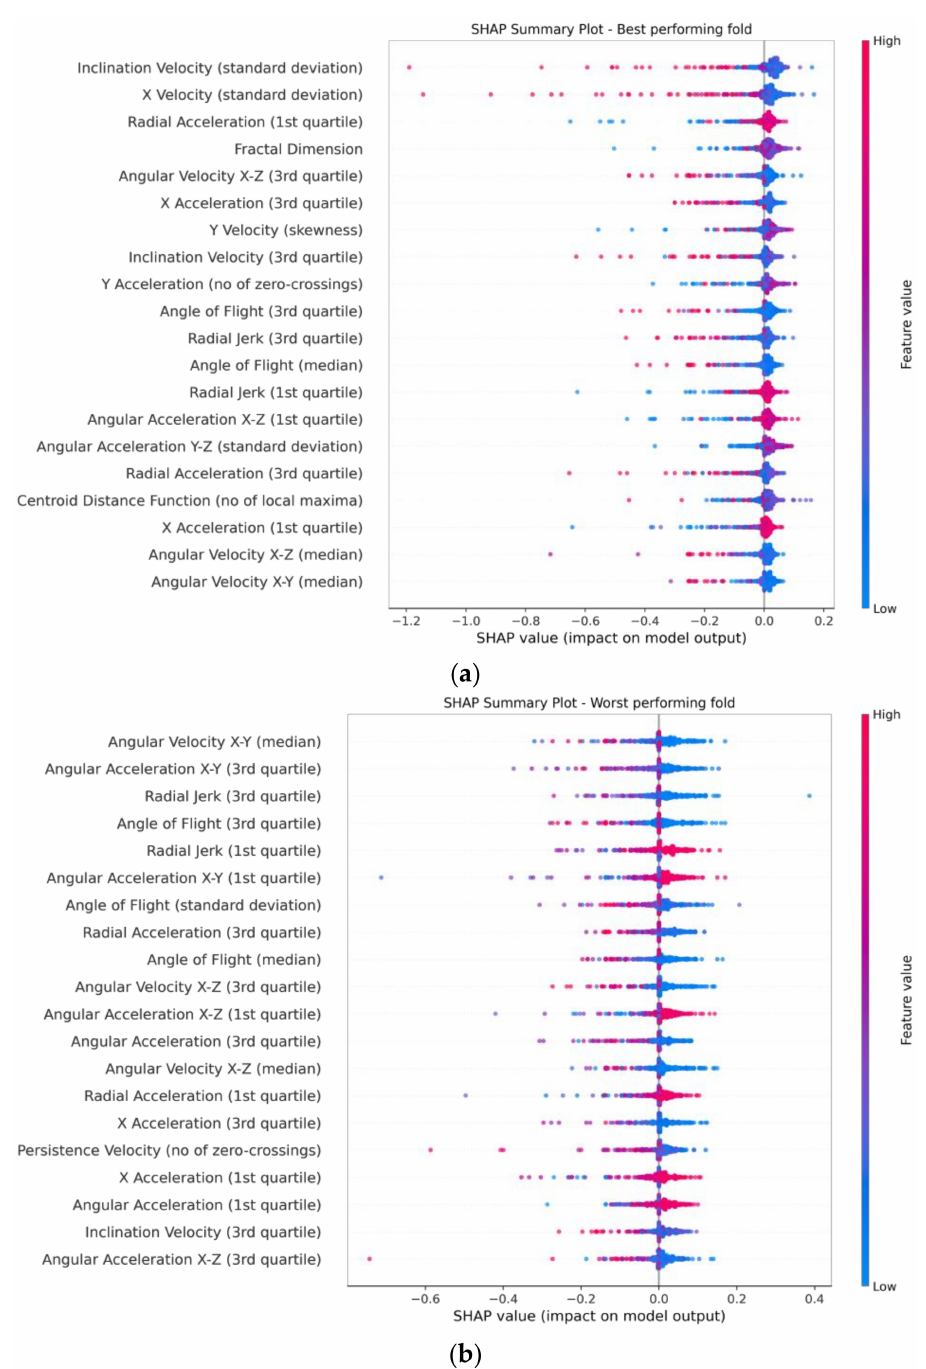
Figure 6. SHAP summary plot displaying the contributions of each feature to the model. The features are ordered by absolute feature contribution and the top twenty are displayed. A full list can be found in Figures S9 and S10. Each dot represents a segment, with its colour displaying its feature value. Positive SHAP values contribute towards the male class, while negative values contribute to the non-male class. ( a ) Summary plot of the best-performing fold. ( b ) Summary plot of the worst-performing